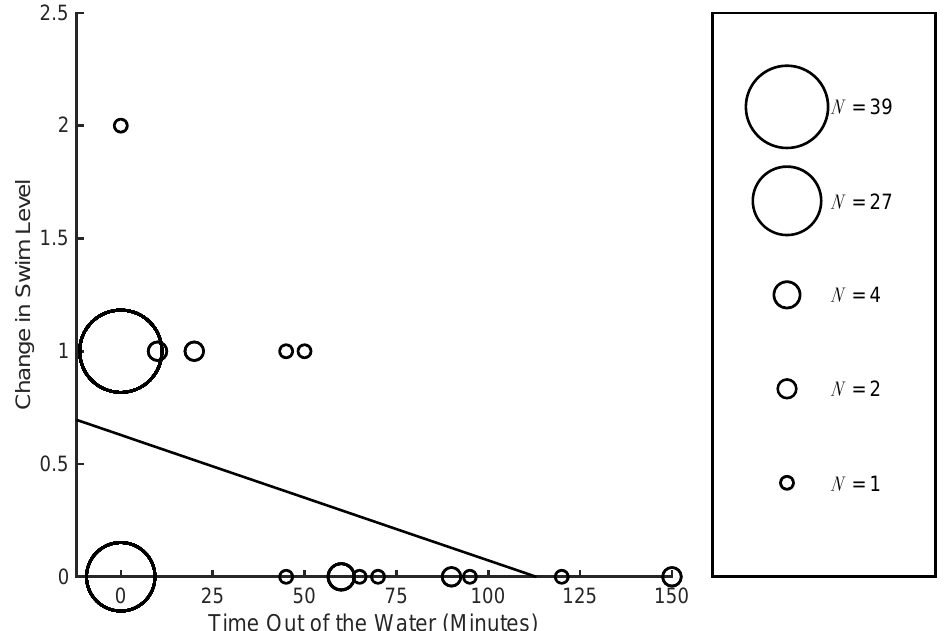
Figure 3. Change in swim level by time out of the water. The size of the circles represents the number of participants with the same change in swim level and time out of the water. The dashed line represents the best linear fit.